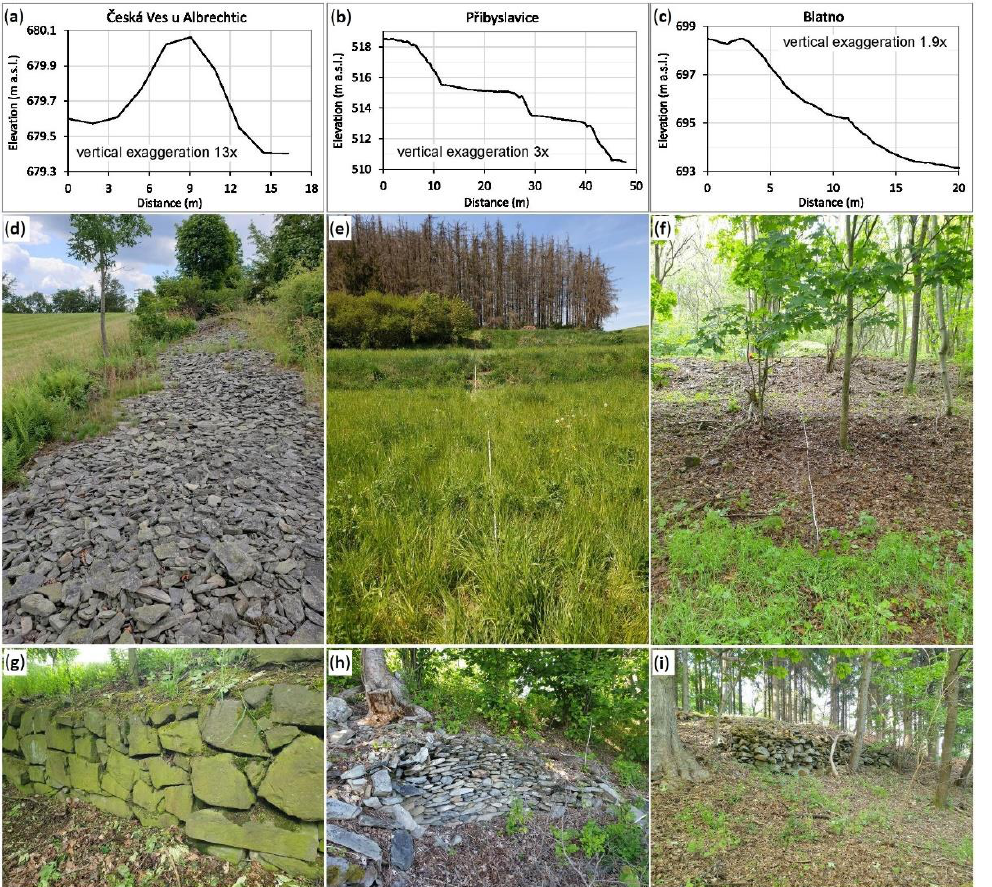
Figure 9. Variability of landforms illustrated by their vertical cross-sections: ( a ) cross-section of piled stone wall [based on ZABAGED® — Altimetry —DMR 5G, ČÚZK, Praha, Czech Republic]; ( b ) array of soil lynchets with visible relief traces of recent tillage on top of the riser [based on acquired LiDAR data]; ( c ) lynchet cross-section with stone accumulation on surface, probable stone wall on top, old farm road in its lower part [based on data acquired by geodetic GPS]; ( d ) piled stone wall at Česká Ves u Města Albrechtic (Jeseníky Mts), site of cross -section ( a ) above; ( e ) soil lynchet at Přibyslavice (Třebíčsko region), site of cross -section ( b ) above; ( f ) lynchet with stone accumulation on the riser at the Blatno site (K rušné Hory Mts), site of cross -section ( c ) above; ( g ) preserved terrace wall at Vitín (České Středohoří Mts); ( h ) remnants of a terrace wall at Česká Ves u Města Albrechtic (Jeseníky Mts); ( i ) remnants of a terrace wall at the Blatno site (Krušné Hory Mts) [photography by Zacharová, 2020].